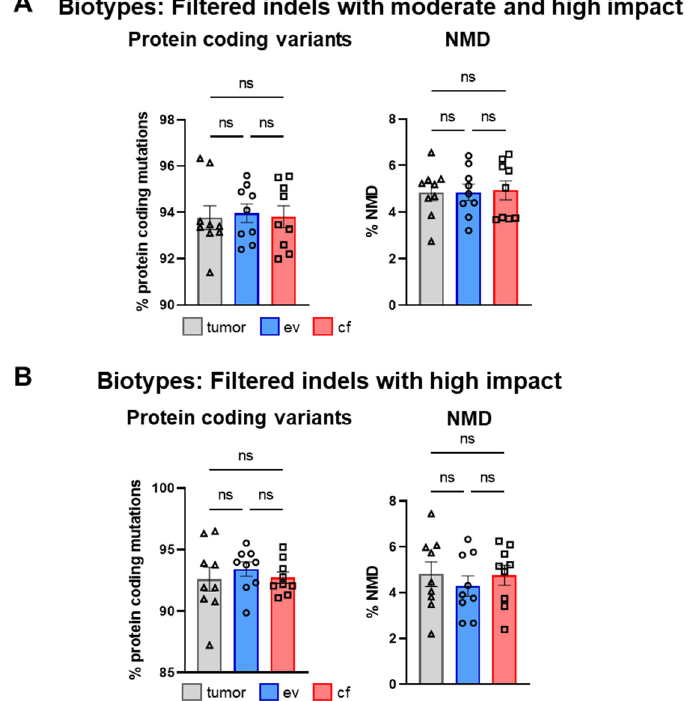
Figure 12. Analysis of biotypes for indels. ( A ) Mean percentage amount of most prevalent biotypes in tumor-, ev- and cfDNA of total biotypes across all patients for indels with moderate and high impact and ( B ) indels with high impact. Statistical tests: ( A , B ) Repeated-measures one-way ANOVA with Tukey multiple comparisons test; ns: no significant difference.